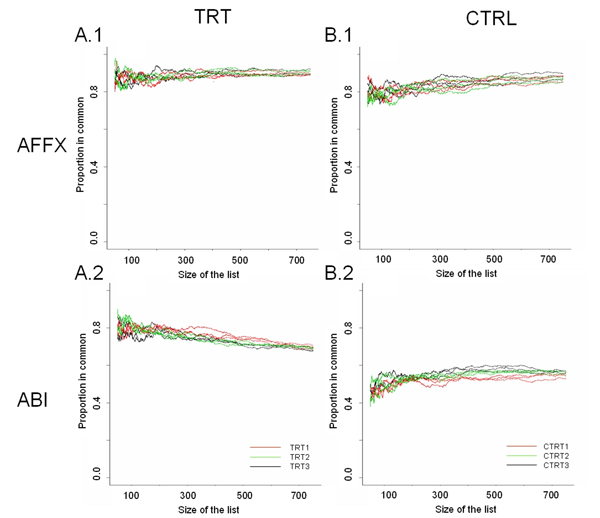
Intraplatform reproducibility. The descriptive CAT (Correspondence At the Top) plots [9] were used to evaluate the array-to-array precision within each microarray platform for the three replicates. CAT Plots describe the proportion of genes in common between replicates as function of list size. To generate CAT Plots on treated samples we used the lists of genes ranked by |log2(fold change)| created by each of the treated samples (TRT) versus a reference, which is one of the control samples (CTRL), both for AFFX (A.1) and ABI (A.2). Similarly we calculated CAT Plots for CTRL samples using one of the TRTs as reference for AFFX (B.1) and ABI (B.2).